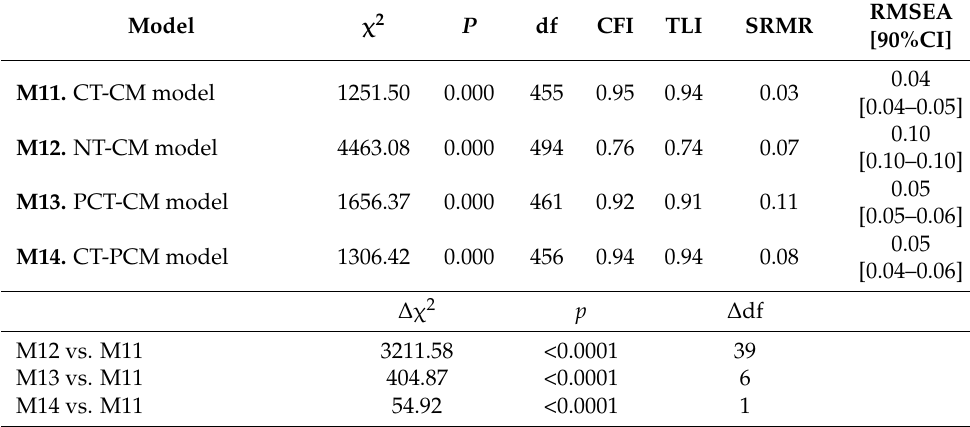
Table 6. Model fit indices for the MTMM models with BAT-C and MBI-GS.